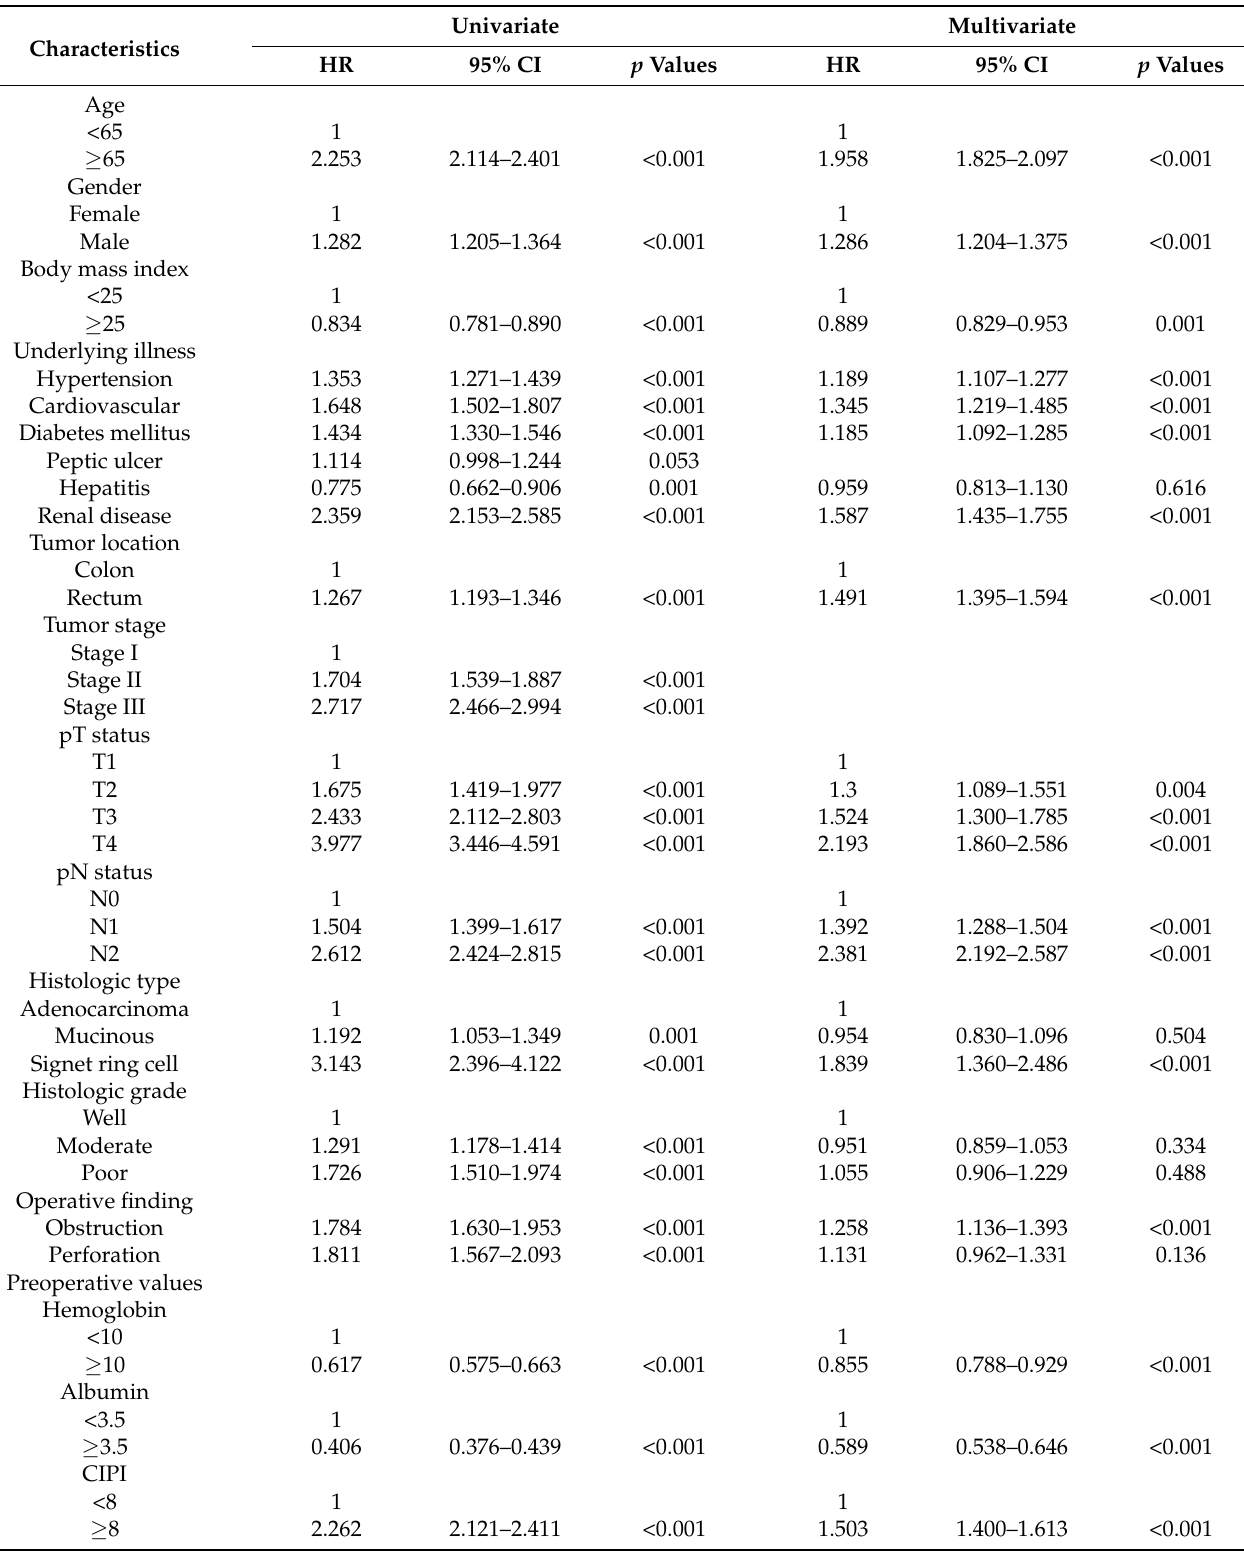
Table 4. Univariate and multivariate Cox proportional hazards regression analyses of prognostic factors for overall